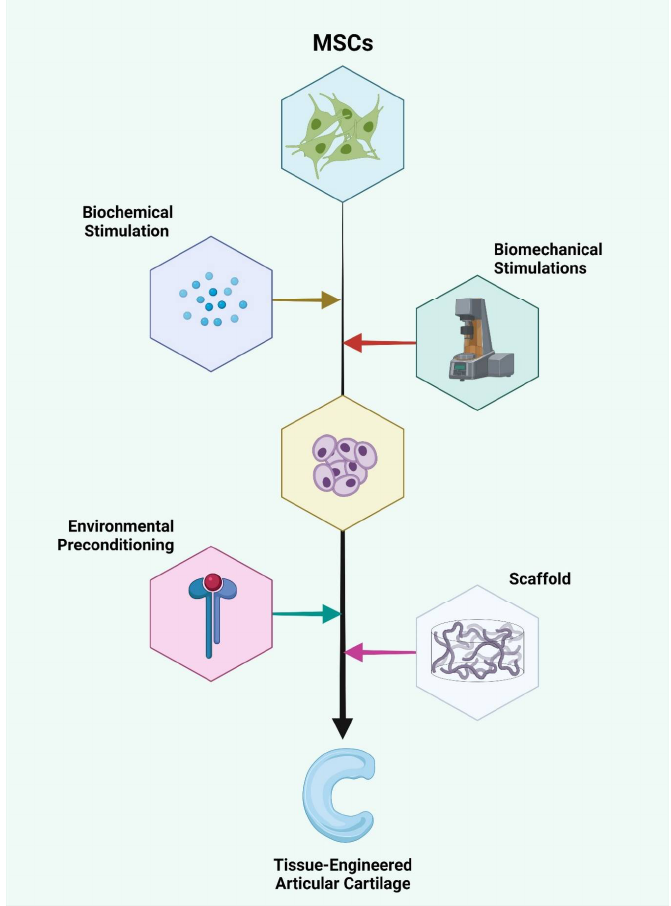
Figure 2. Lineage manipulation of different sources of MSCs with biochemical stimulation using mediators, such as IGF, FGF, TGF-β, BMP, Loxl2, c-ABCs, and biomechanical stimulations, such as compressive, tensile, or shear loading, along with the necessary hydrostatic pressure results in the formation of the chondrocyte tissue complex. The chondrocyte complex is further subjected to en- vironmental preconditioning using chemokines, such as IL-1, to sensitize them to the target milieu when delivered with or without supporting scaffold, resulting in the formation of the tissue-engi- neered articular cartilage. Created with BioRender.com (accessed on 20 December 2021).